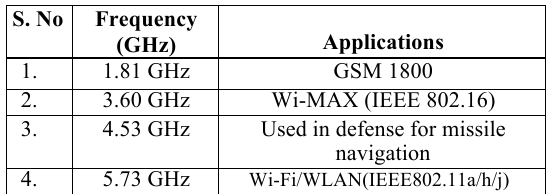
Table 3. Applications for different simulated frequencies